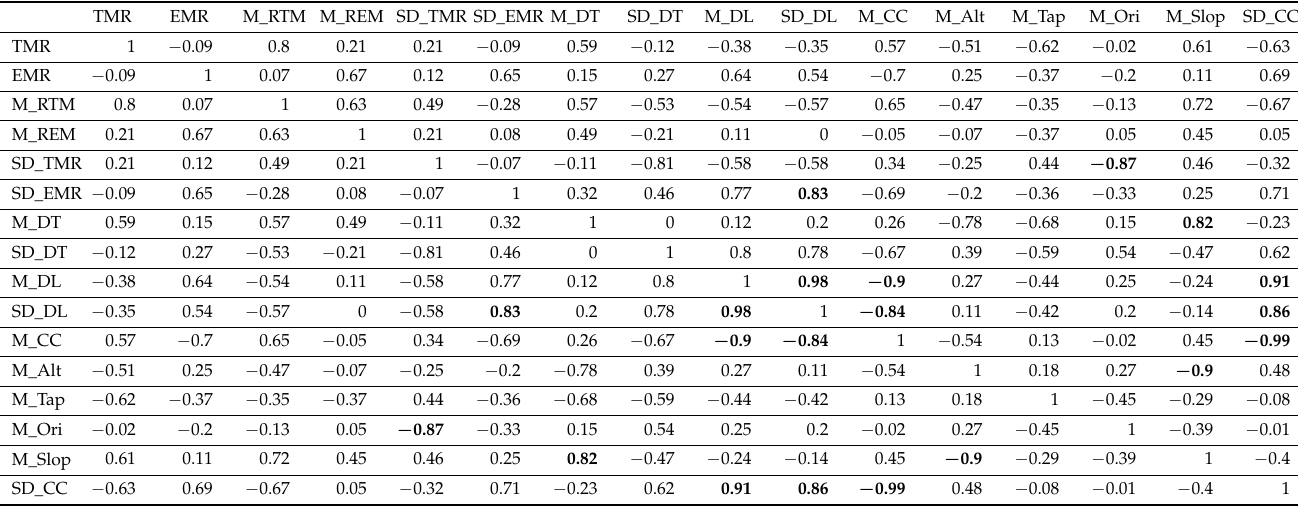
Table A2. Correlation analysis values between alpha diversity and environmental variables. TMR = Terrestrial mosses rich- ness; EMR = Epiphytic mosses richness; M_RTM = Mean richness of terrestrial mosses; M_REM = Mean richness of epiphytic mosses; SD_TMR = Standard deviation of the terrestrial mosses richness; SD_EMR = Standard deviation of epiphytic mosses rich- ness; M_DT = Mean daily temperature; SD_DT = Standard deviation of the daily temperature; M_DL = Mean of the daily light; SD_DL = Standard deviation of the daily light; M_CC = Mean of the canopy coverage; SD_CC = Standard deviation of the